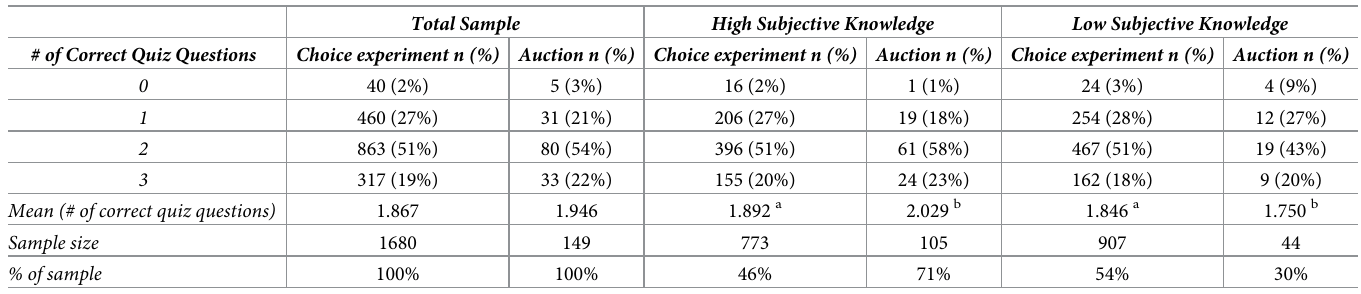
Table 1. Summary results of the subjective and objective knowledge measures.